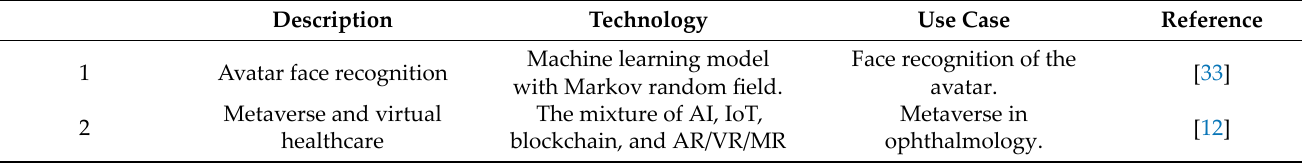
Table 1. Comparative analysis of some of the technologies and use cases. Description Technology Use Case